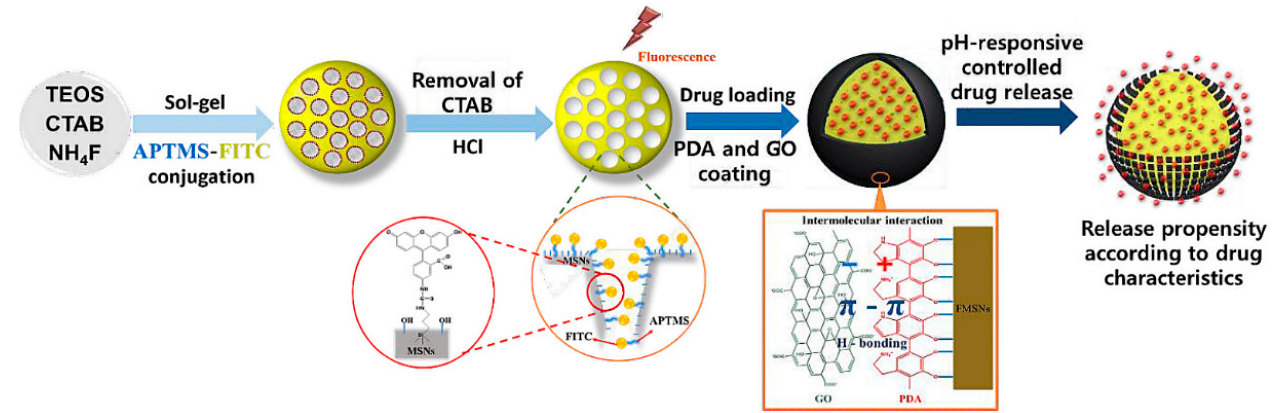
Figure 5. Schematic snapshots illustrating the fabrication process of MSNs grafted with APTMS-FITC conjugates, followed by coating of the PDA and GO double layer, and their controlled drug release mechanism. Reprinted/adapted from ref. [321] with permission from RSC—Royal Society of Chemistry, 2020.